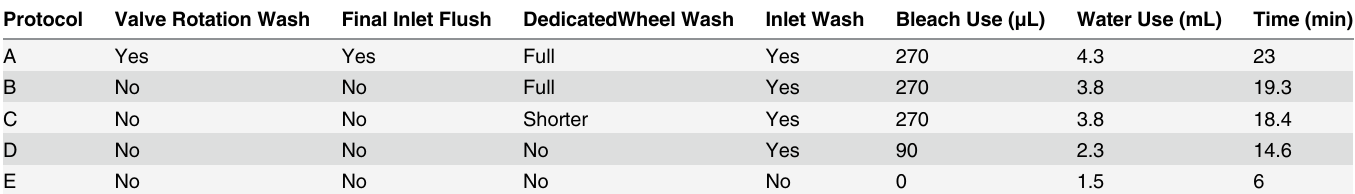
Table 1. Feature comparison of rzPCR cleaning